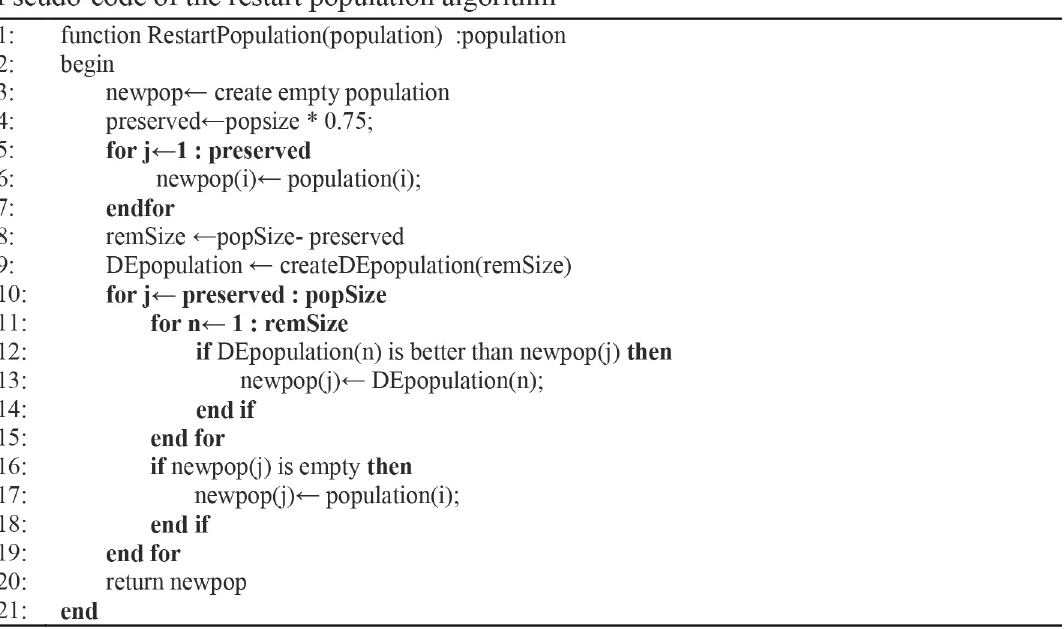
Fig 11. Pseudo-code of the restart population